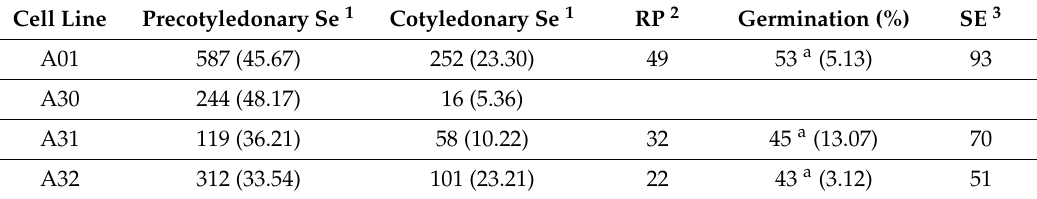
Table 2. Somatic embryo (se) maturation and germination in selected embryogenic cell lines of Abies alba Mill. (the number of somatic embryos was calculated per 1 g of fresh